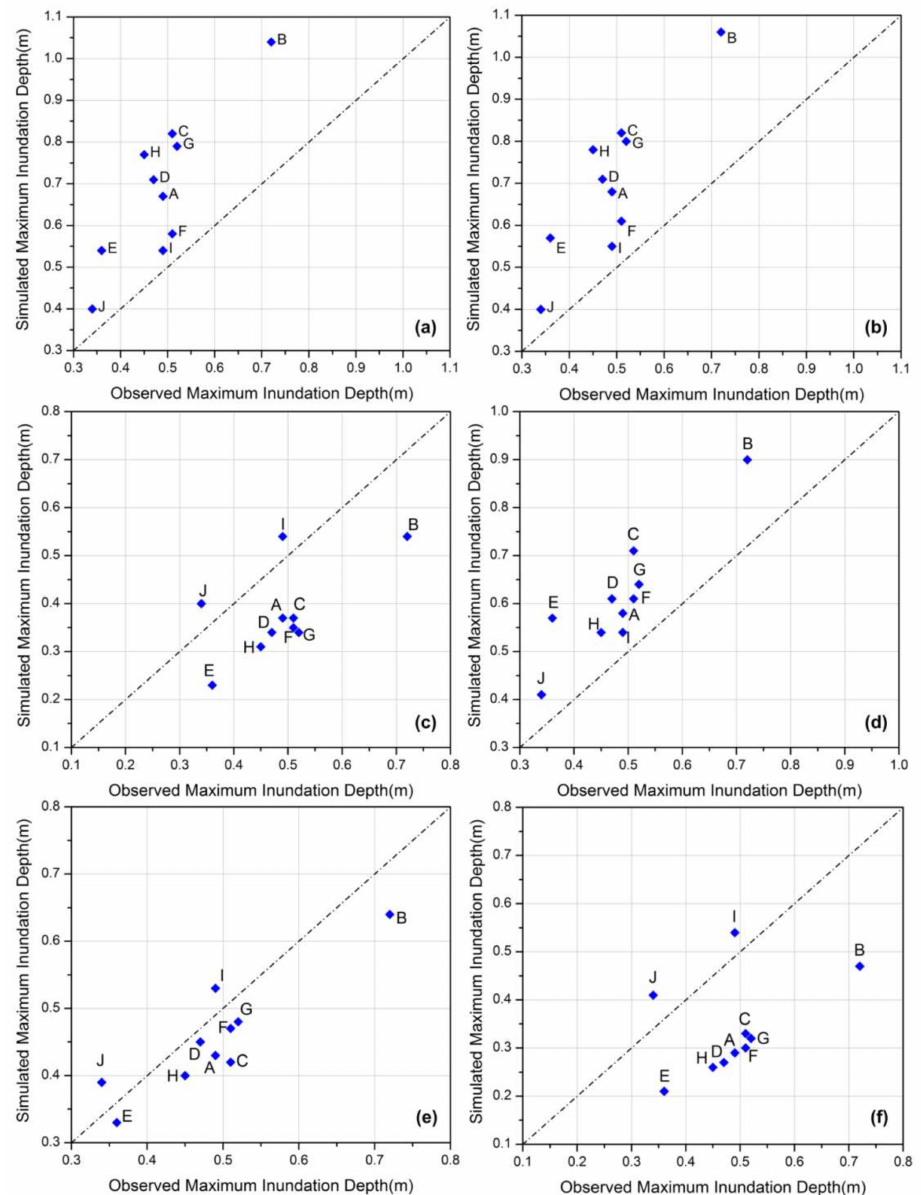
Figure 15. A comparison of observations and simulated maximum inundation depth at each monitoring point (from points A to J) resulted from different building treatment methods: ( a ) BB method; ( b ) BH method; ( c ) IBTA0.4 method; ( d ) IBTA0.6 method; ( e ) IBTA0.4R method; and ( f ) BR